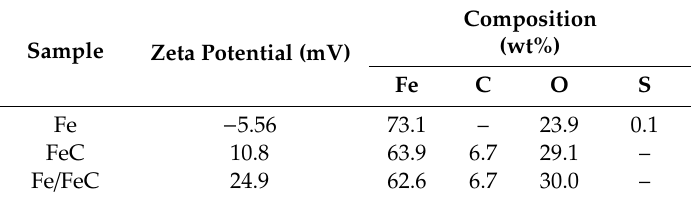
Table 2. Zeta potential and composition by EDS measurements of the solids studied.